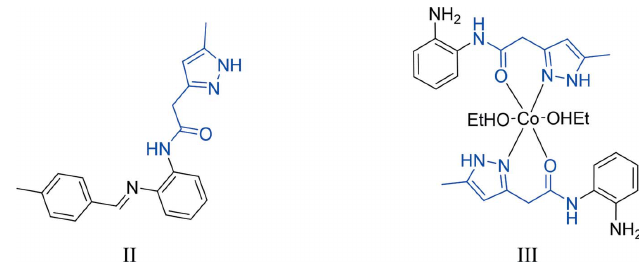
Figure 8 Structures similar to (I): (II) (CSD refcode XITFUE) and (III) (CSD refcode YODZEZ) obtained in the database search. The search fragment is indicated in blue.